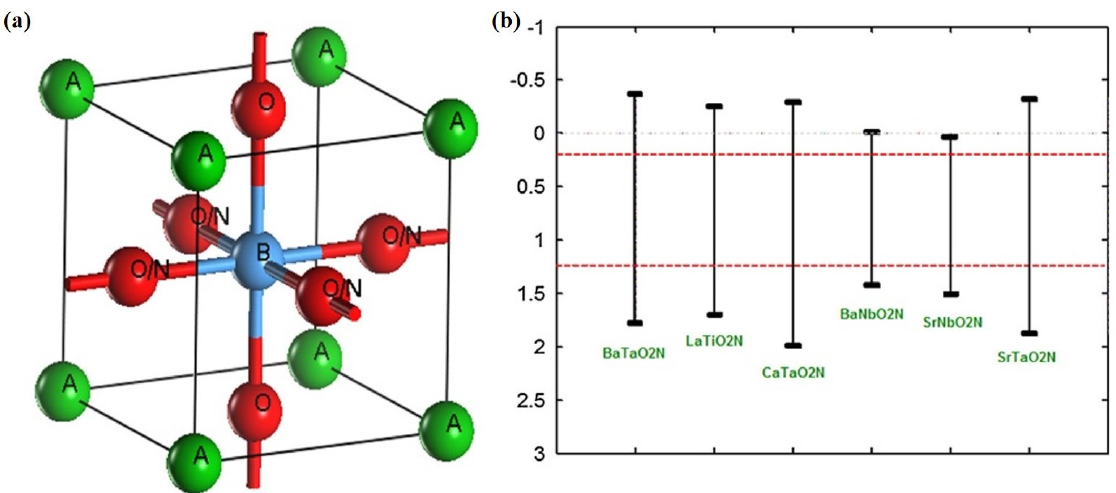
Figure 4. ( a ) Crystal structure of perovskite oxynitride; ( b ) band gap structure of perovskite oxyni- trides. Reproduced with permission [86], Copyright 2016, Elsevier.